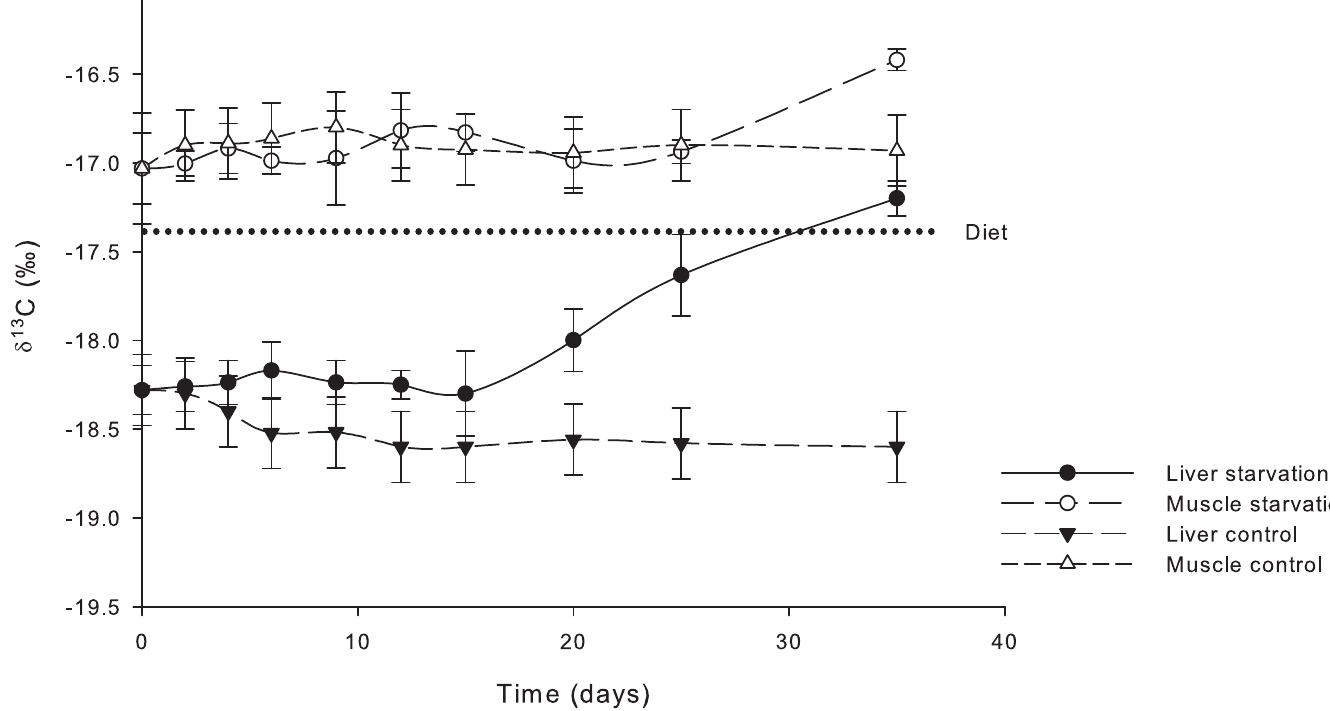
Fig 1. δ 13 C (‰) in bulk muscle and liver tissues of S . lalandi during 35 days of starvation. Liver starvation, Muscle starvation, Liver control and Muscle control, averageand